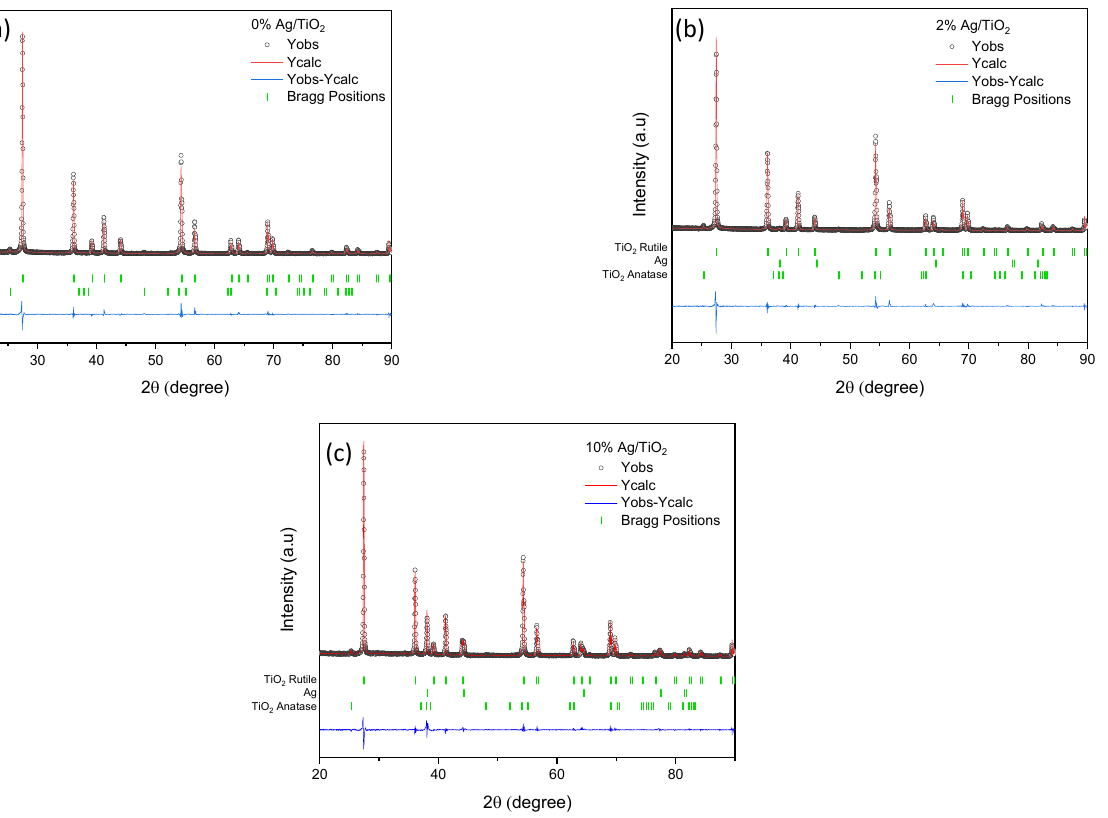
Figure 3. DRX spectrum for samples 0% Ag/TiO 2 ( a ), 2% Ag/TiO 2 ( b ), and 10% Ag/TiO 2 ( c ).